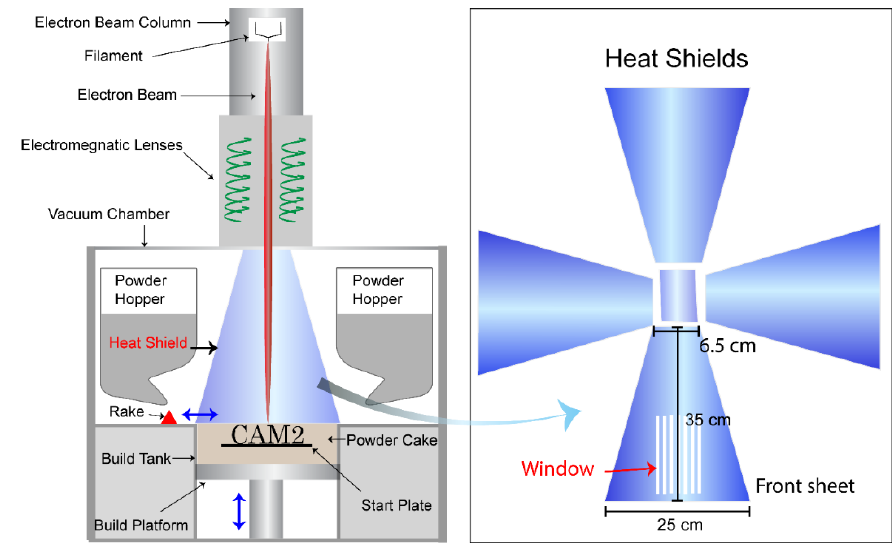
Figure 1. Schematic of EBM machine with an illustration of the heat